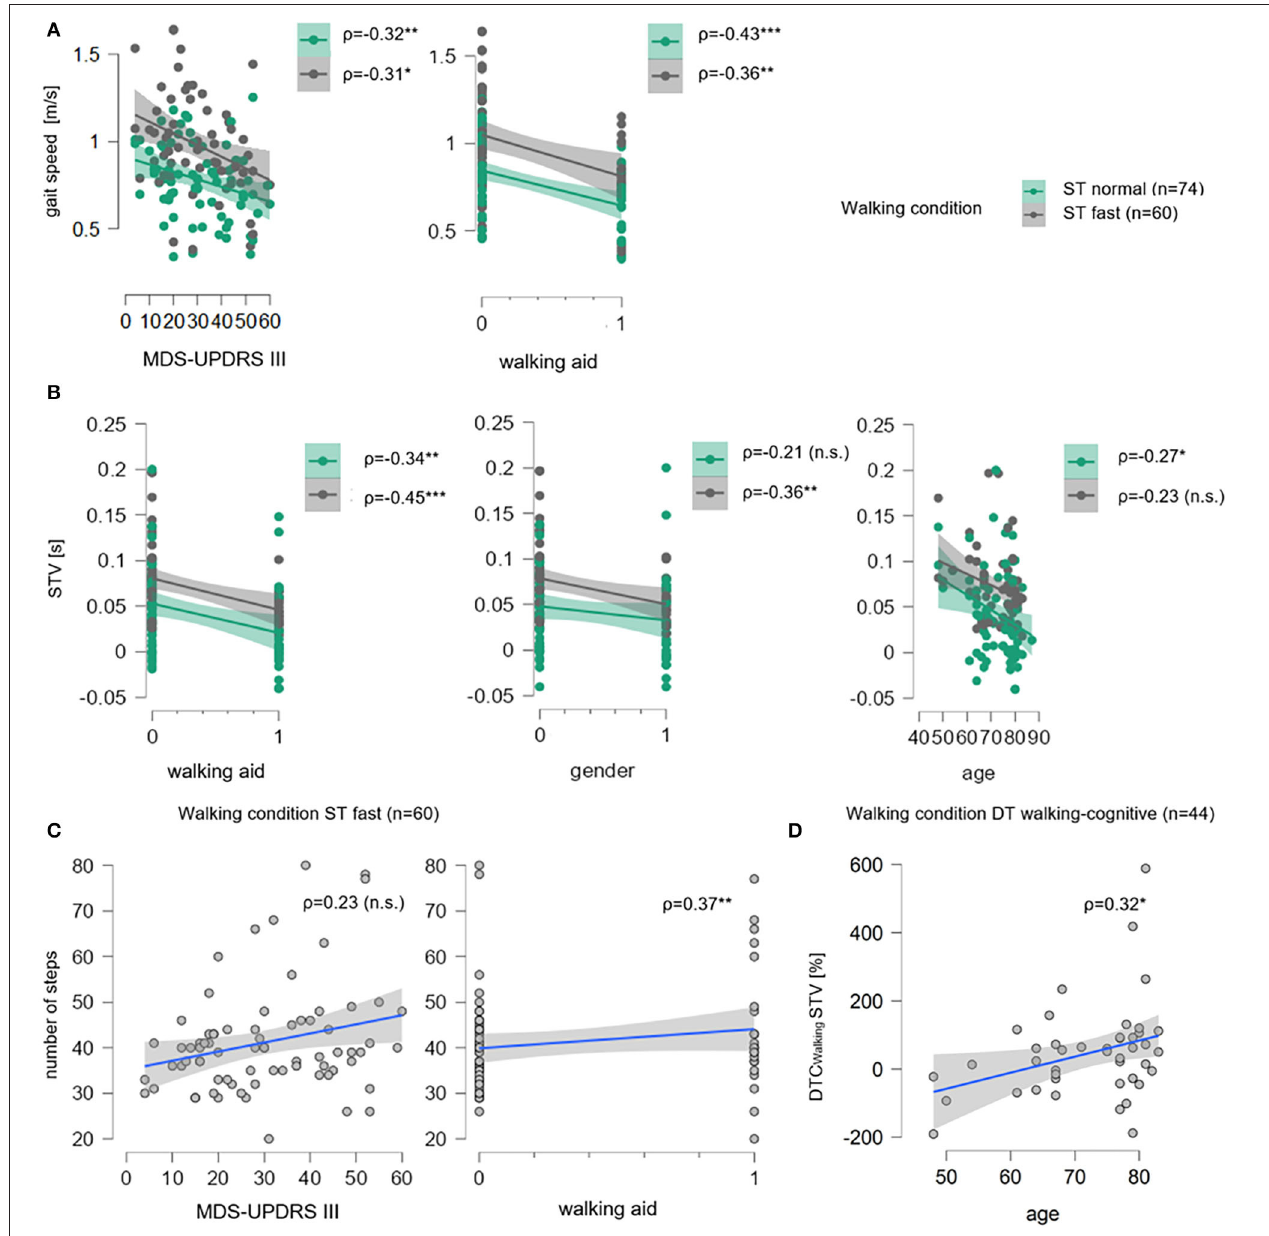
FIGURE 3 | Correlation plots for significant multiple linear regression models for gait speed, STV, number of steps and DTC Walking for STV. In (A) , for single task normal pace walking condition (ST Normal, green) and single-task fast pace condition (ST Fast, gray), gait speed (in meter per seconds, m/s) is shown on the ordinates, the total score of the Movement Disorder Society-revised version of the motor part of the Unified Parkinson’s Disease Rating Scale (MDS-UPDRS III) and walking aid (0 = “no walking aid,” 1 = “walking aid”) are on the abscissas. Sample size n is given as well as Spearman’s rank correlation ( ρ ) between gait speed and each parameter. For each condition, data points (dots) and regression lines with confidence intervals (lines with surrounding boxes) are shown, and significant correlation coefficients are marked with * (level of significance p ≤ 0.05), ** (level of significance p ≤ 0.01), and *** (level of significance p ≤ 0.001), non-significant ones are marked with (n.s.). In (B) , the same is shown for step time variability (STV in seconds, s) on the ordinates, and walking aid, gender (0 = “men,” 1 = “women”), and age on the abscissas. In (C) for ST fast pace number of steps is shown on the ordinates, MDS-UPDRS III and walking aid are on the abscissas. Here, data points (gray dots) and regression lines with confidence intervals (blue lines with surrounding gray boxes) are given for each parameter. In (D) , the same is shown for DT walking-cognitive walking condition for dual-task costs while walking in percentage (DTC Walking , %) of STV on the ordinate and age on the